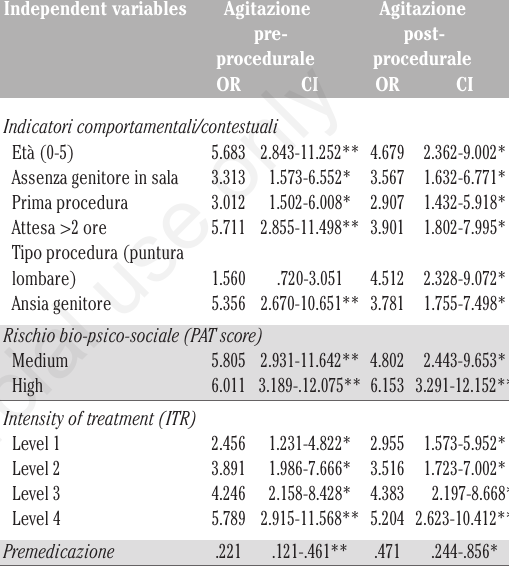
Tabella 1. Multi-variable associations of Indicatori comporta- mentali/contestuali, rischio bio-psico-sociale, intensità di trat- tamento with Agitazione pre-post procedurale del